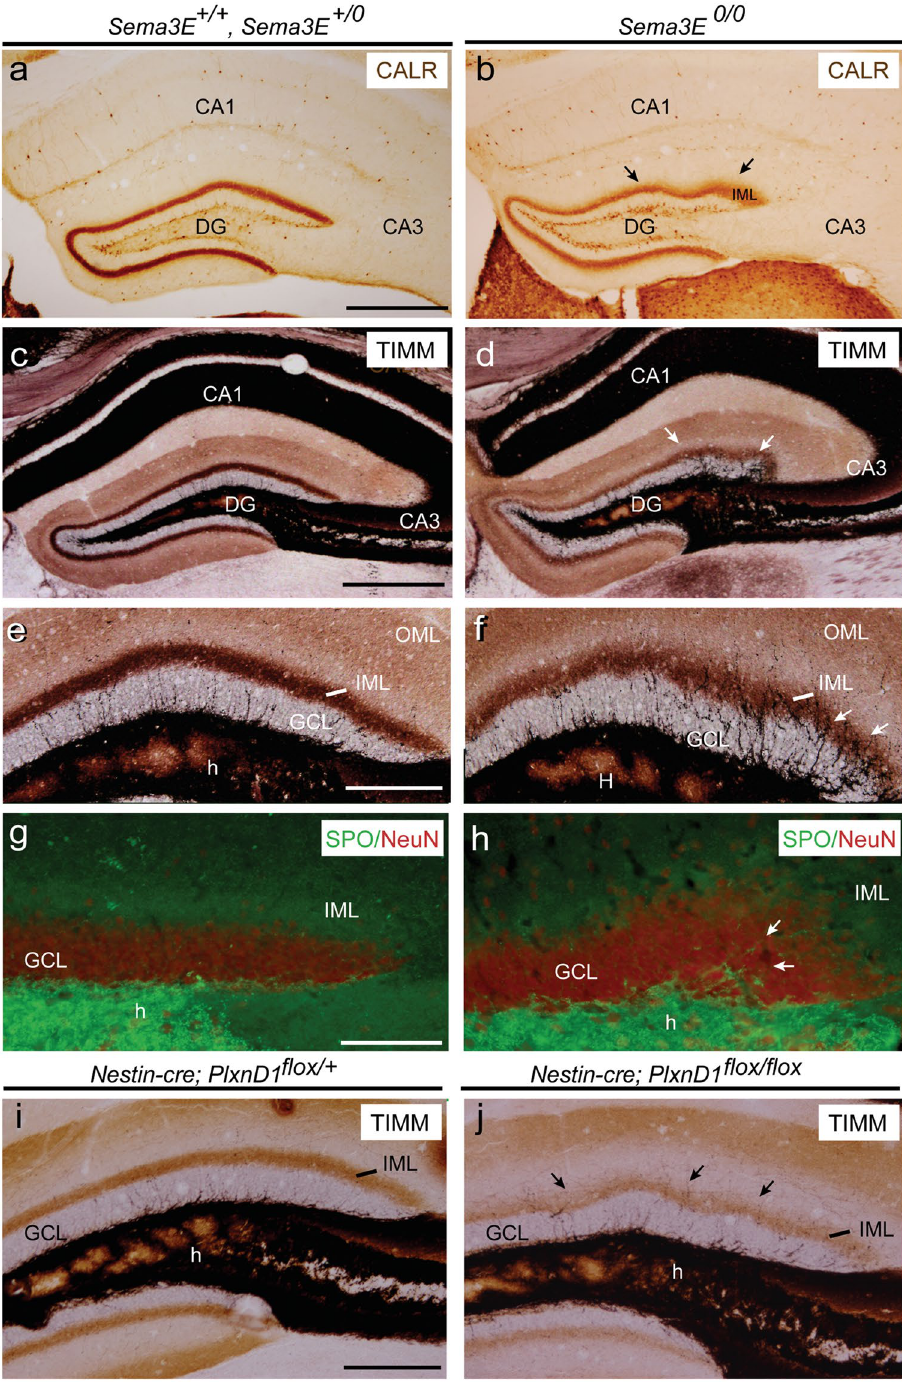
Figure 6. ( a,b ) Examples of α -Calretinin immunostaining in the hippocampus proper and dentate gyrus of adult Sema3E + / + and Sema3E + /0 ( a ) and Sema3E 0/0 ( b ) mice. Note the presence of several waves in the IML of the suprapyramidal blade (arrows in b ). ( c–f ) Photomicrographs illustrating the pattern of selenite-silver staining (TIMM) in Sema3E + /0 and Sema3E + / + ( c , e ) and Sema3E 0/0 ( d , f ) mice. Note the numerous ectopic mossy fibers crossing the granule cell layer entering the molecular layer of mutant mice (arrows in d , f ). ( g – h ) Double immunolabeling of Synaptoporin (SPO, green) and NeuN (red) in the dentate gyrus of Sema3E + / + and Sema3E + /0 ( g ) and Sema3E 0/0 ( h ) mice showing ectopic mossy fibers crossing the granule cell layer in mutant mice (arrows in h ). ( i – j ) High-power photomicrographs illustrating the pattern of selenite-silver staining (TIMM) in control ( Nestin-cre ; PlxnD1 flox/ + ) and PlexinD1-deficient ( Nestin-cre ; PlxnD1 flox/flox ) mice. Abbreviations as in Figs 1–5 and CALR = calretinin; SPO = synaptoporin. Scale bar: a = 500 μ m pertains to b ; c = d = 500 μ m. e = 150 μ m pertains to ( f , i – j ); g = h = 100 μ